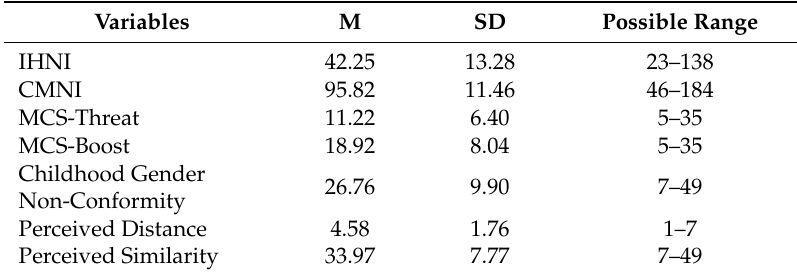
Table 2. Descriptive statistics for the study